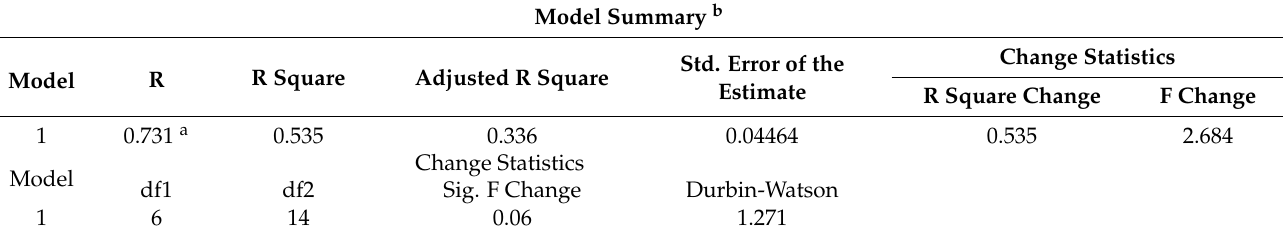
Table 9. The model of analysis for Romania.